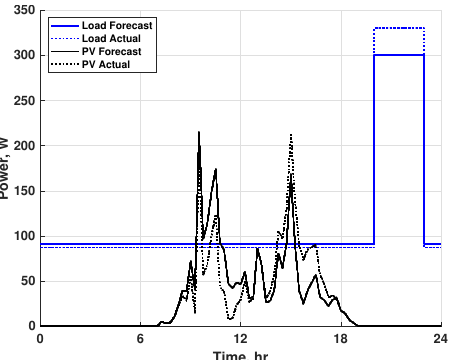
Figure 4. The electrical load and PV generation for the Forecast Error